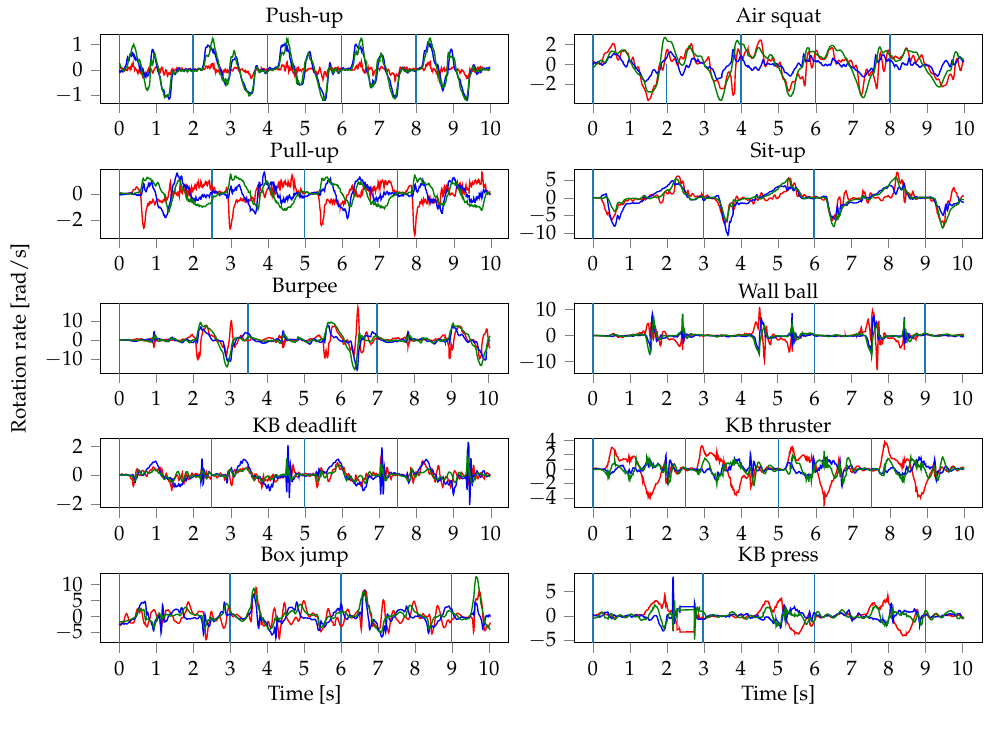
Figure A2. Gyroscope raw readings for 10 s for all exercises.